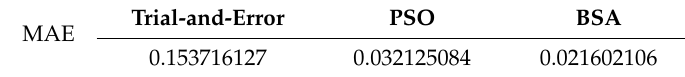
Table 4. Values of output error by different techniques.